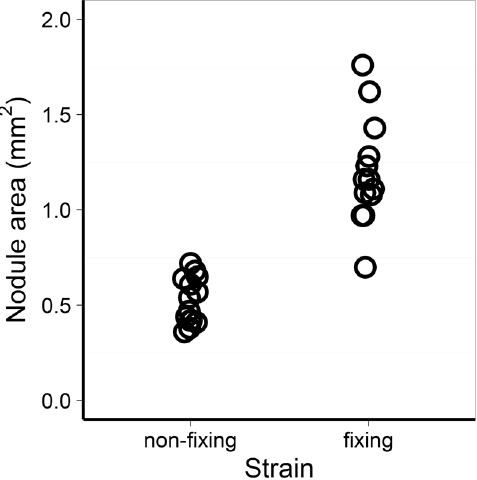
Figure 3. Legumes sanction non-fixing nodules. Nodules containing the fixing strain were significantly larger than nodules containing the fixing strain (paired t-test, t 13 = 7.7176, p = 3.307 × 10 − 6 ), indicating that pea plants preferentially allocated resources to fixing nodules.